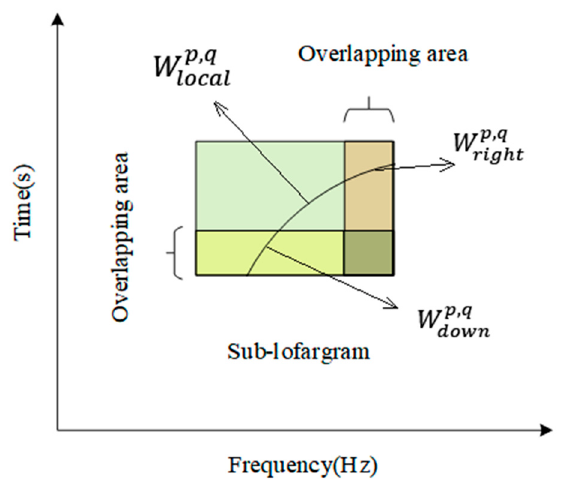
ff erent frequency point sets in sub-lofargram. Figure 6. Diagram of different frequency point sets in sub-lofargram. Figure 6. Diagram of di